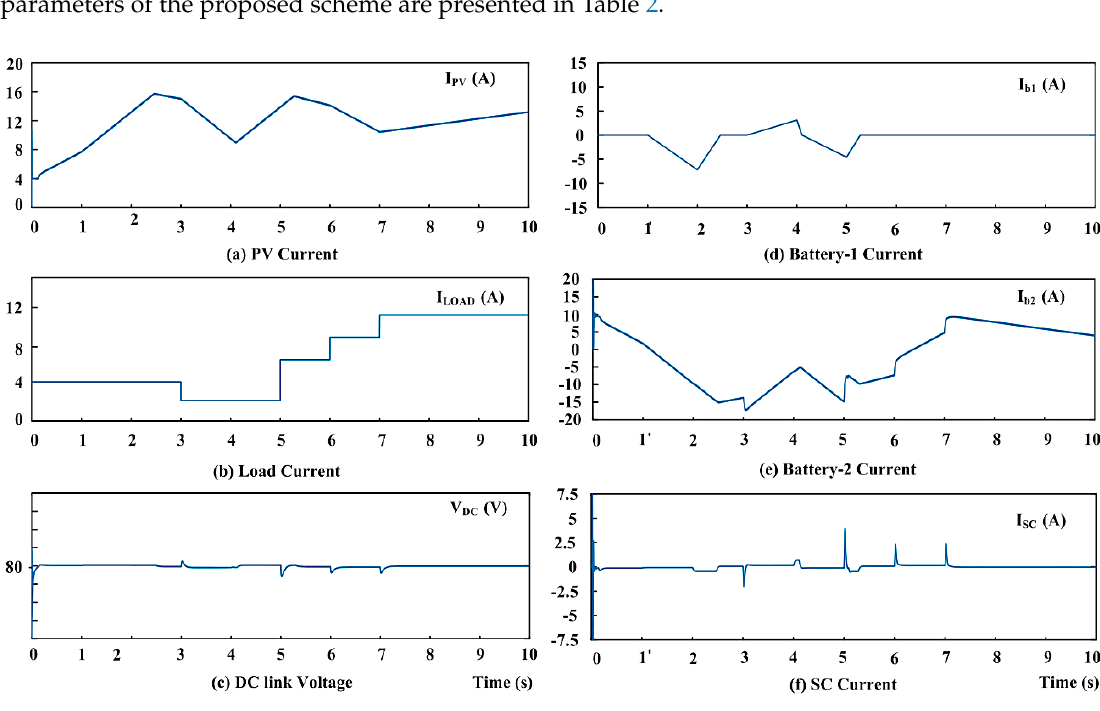
Figure 12. Analysis between the boost converter and IBC results. 5.2. Real-Time HIL Results In the simulated model, the PV system rating of 40 V and the battery of ratings 48 V are considered. The IBC and bidirectional converters are operated to interlink the PV and batteries with the DC grid. The DC link reference voltage is 80 V and a variable source is connected to the DC link. The Real-Time HIL Simulator results are presented in Figures 13–15. The irregular nature of the PV current profile varying between instants t 1 – t 10 by 4 A/div is shown in Figure 13a, and Figure 13b shows the randomly varying load current profile by 4 A/div. During the variable PV and/or load conditions ( P pv > P l or P pv < P l ), there is a necessity to sustain power stability and provides fast DC voltage regulation into the system. At time t 3 , the load current is suddenly decreased by 2 A/div and